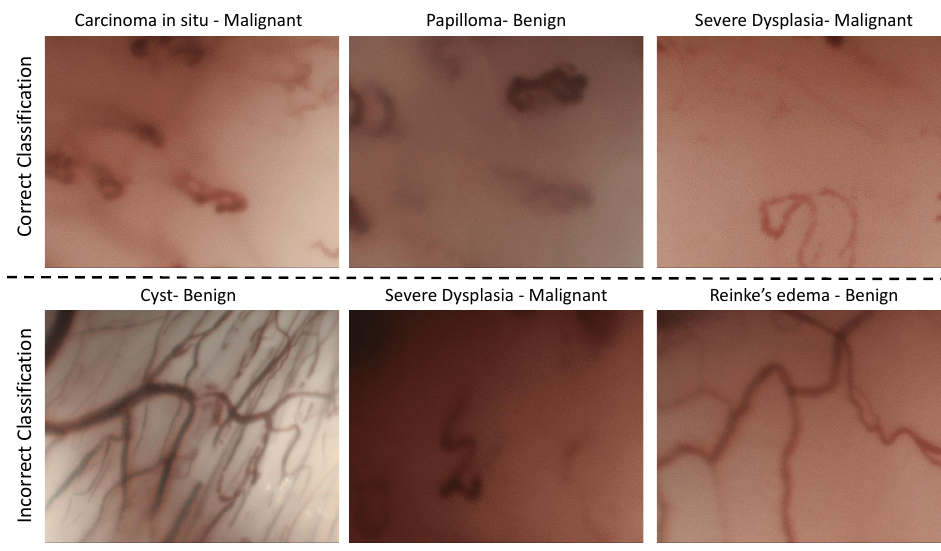
Figure 3. The example of correct and incorrect classification of CE-NBI images in Experiment 3.